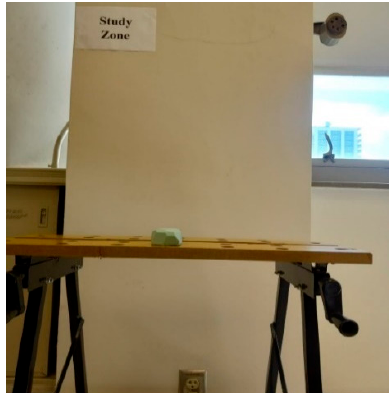
Figure 4. Placement of one of the proximity sensors in the ‘study-zone’.